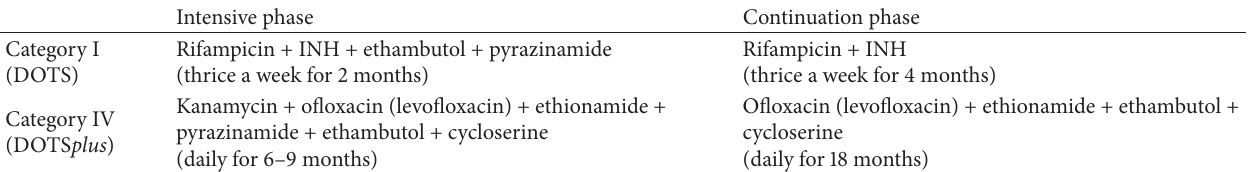
Table 1: Category I (DOTS) and category IV (DOTS plus ) regimen advocated under RNTCP for new TB and MDR TB patients, respectively.